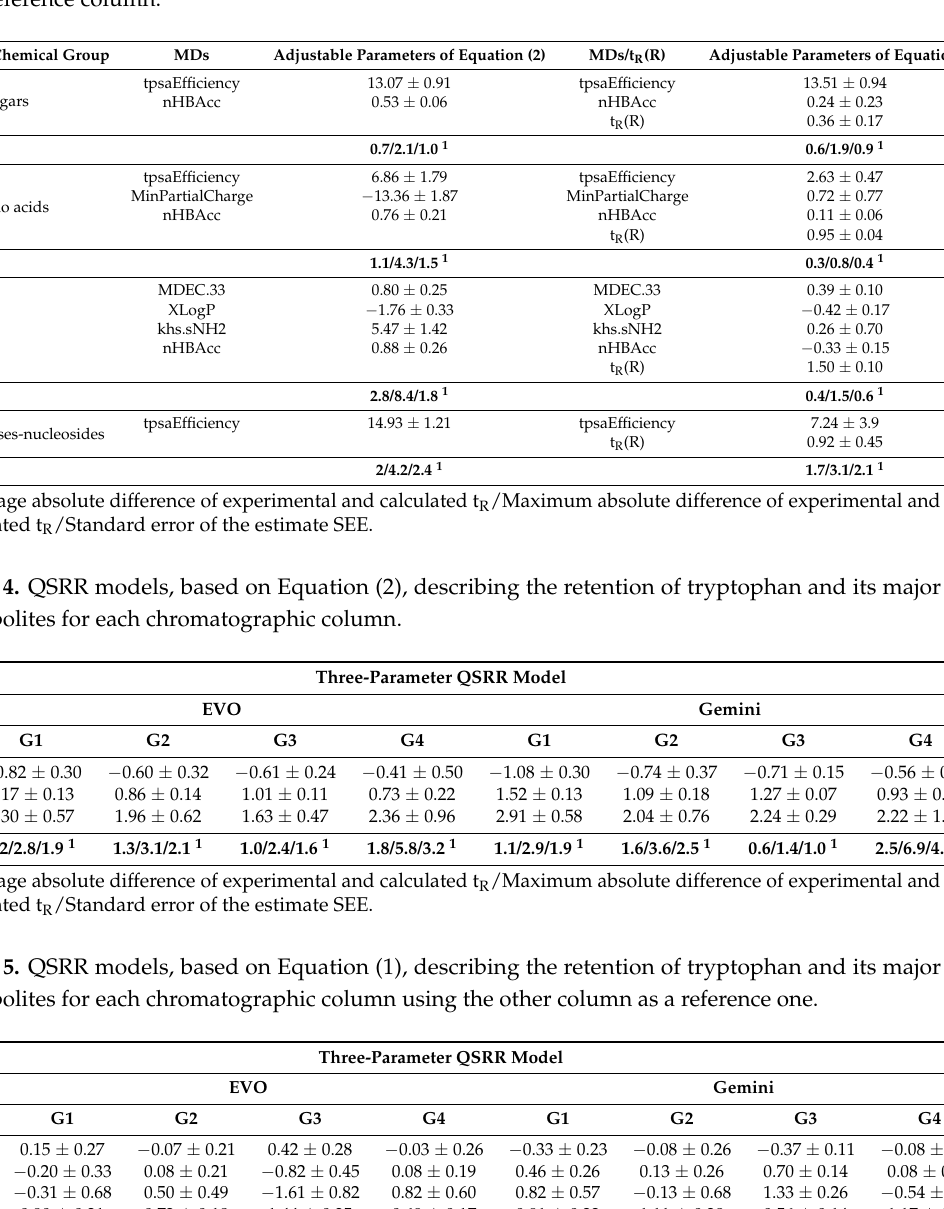
Table 3. QSRR models describing the retention of each of four groups of chemically related compounds for Amide column based on Equations (1) and (2), where in Equation (1) the Bare Silica column is used as a reference column.